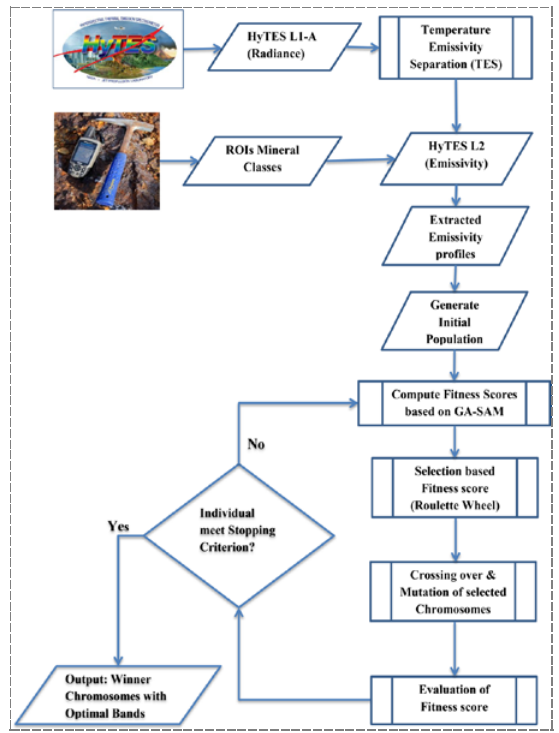
Figure 2. The methodology